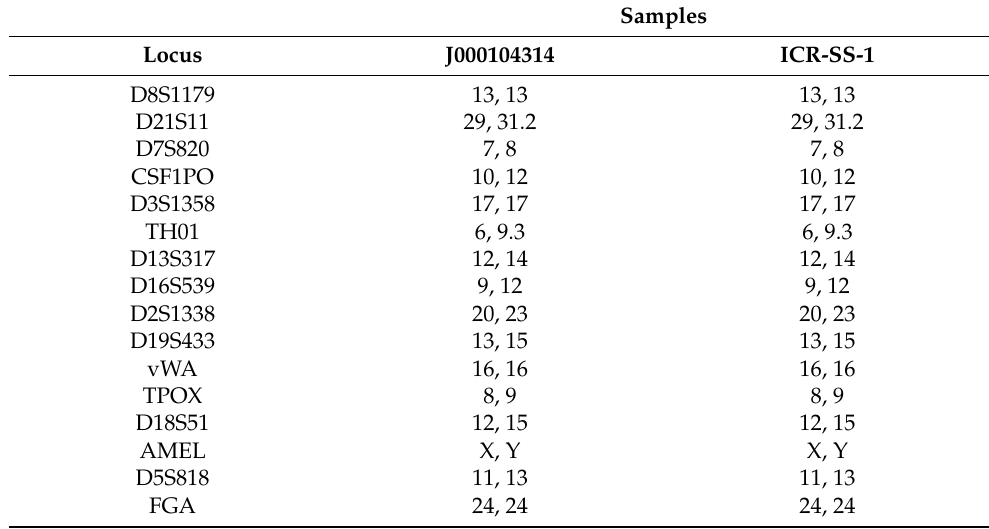
Table 6. Short tandem repeat profile of J000104314 PDX tumour and ICR-SS-1 cell line.